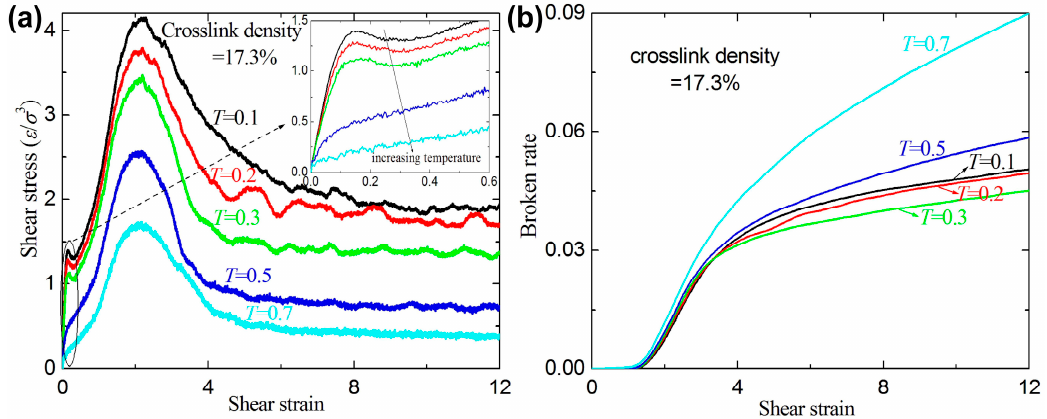
Figure 9. ( a ) The shear stress-strain curves for a given crosslink density of 17.3% at different temperatures; and ( b ) the broken ratio versus temperature.